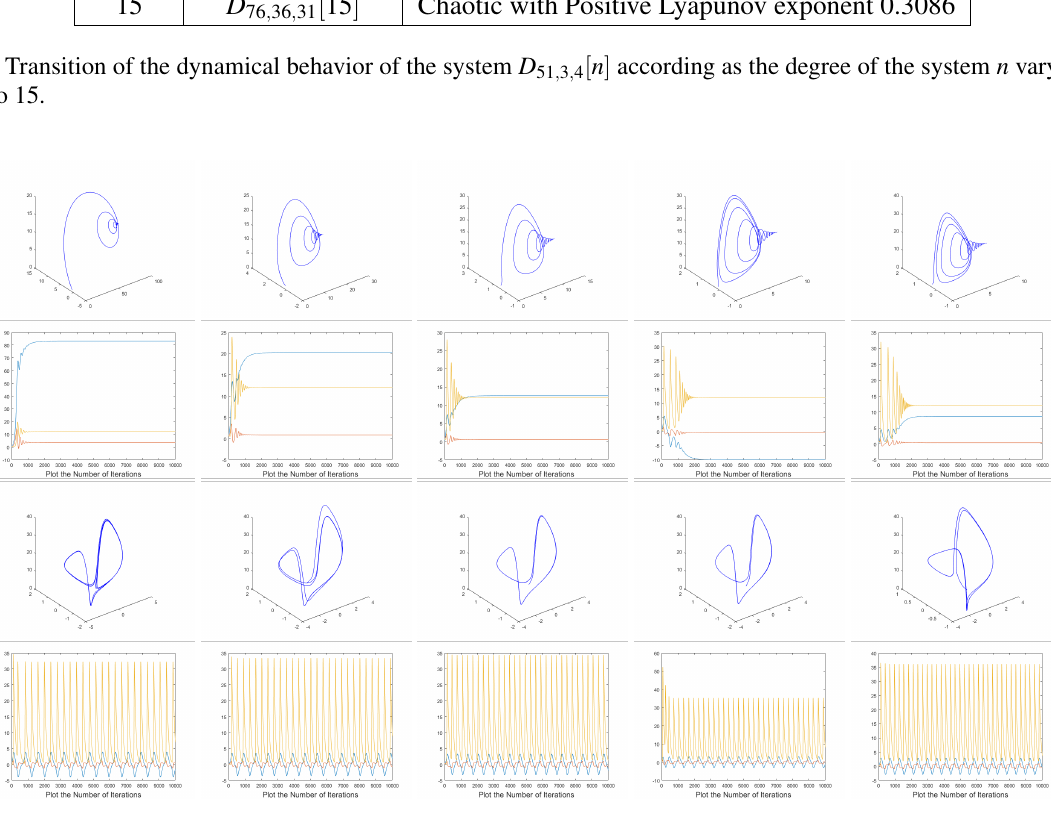
Fig. 15 Trajectories and 3D plots are plotted for the system D 3 , 12 , 24 [ n ] where the degree of the system n varying from 1 to